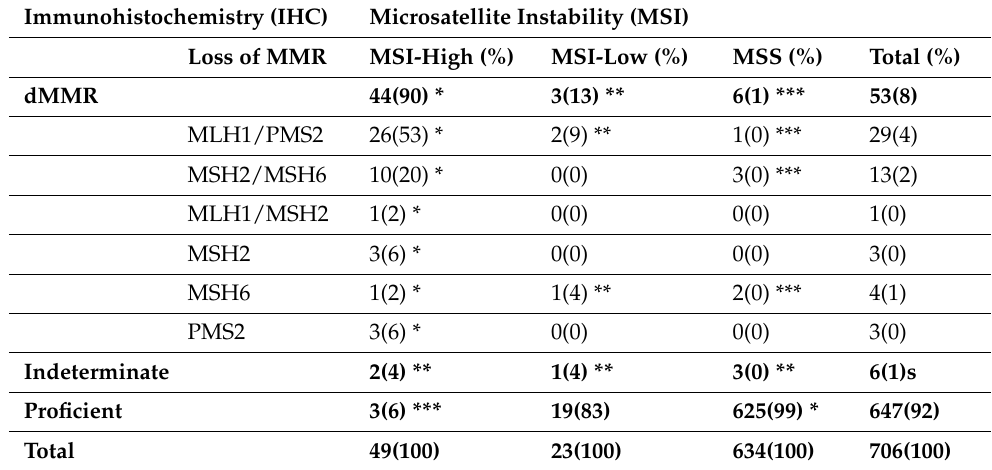
Table 2. Stratification of microsatellite instability results by immunohistochemistry (IHC). Immunohistochemistry